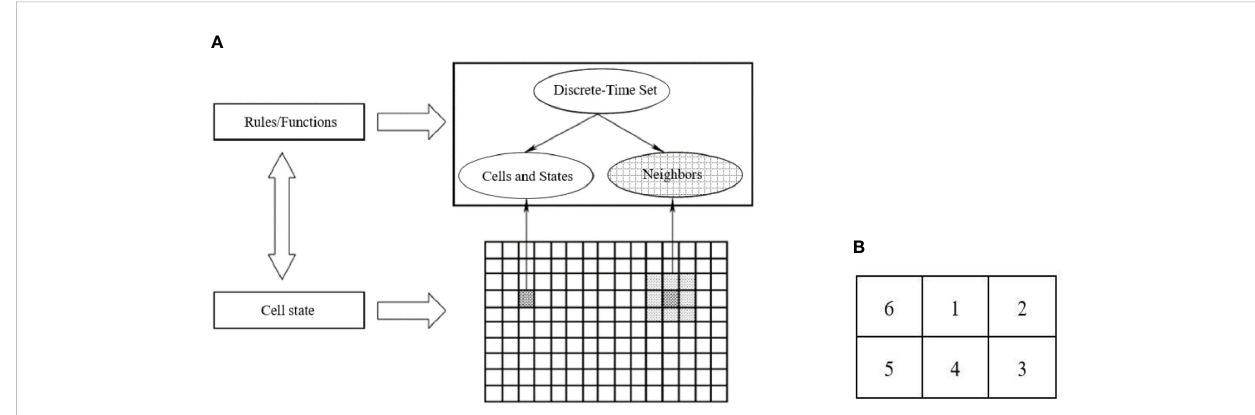
FIGURE 3 Cellular Automata model process. (A) The Composition diagram element of Cellular Automata. (B) Schematic diagram of evolution rules of Moore neighboring